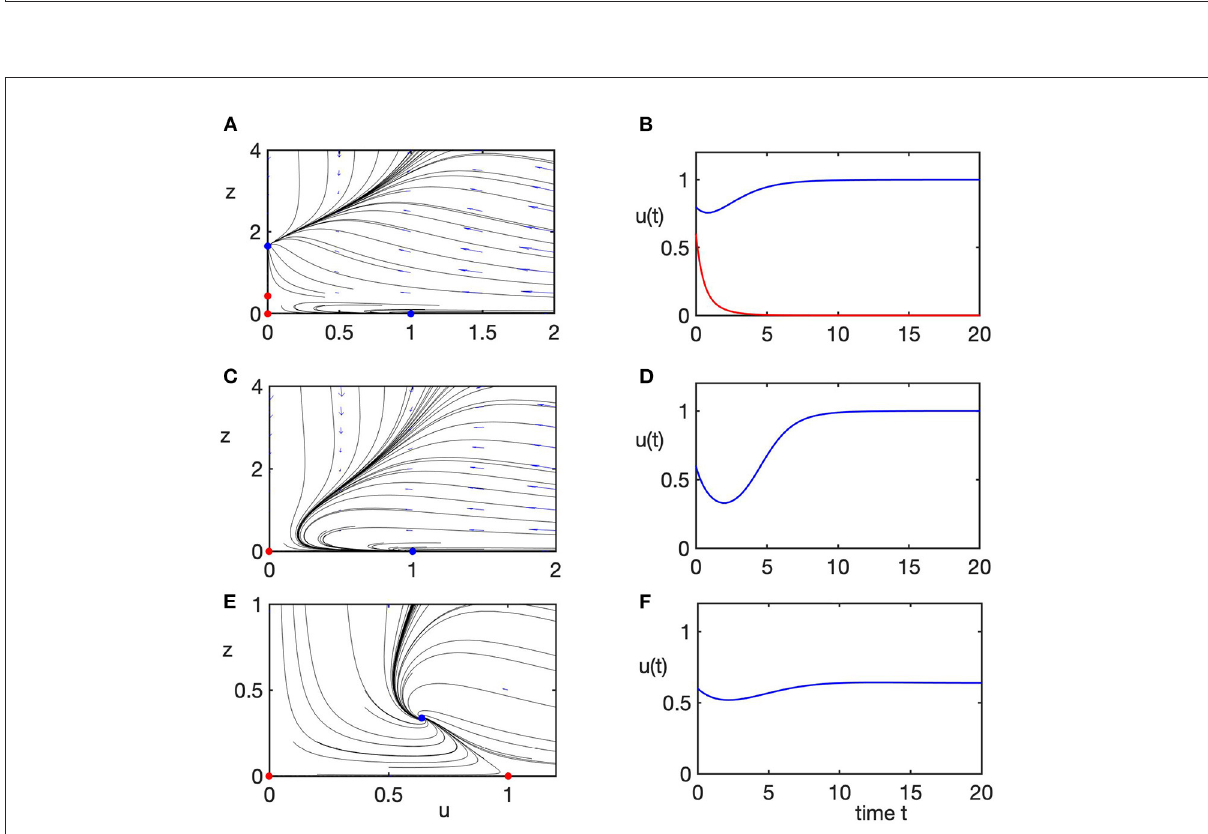
FIGURE4 Phase planes (left column) of the transformed system (Equation 5) and the corresponding numerical solution (right column) of the rescaled original system (Equation 4), illustrating different dynamical regimes listed in Figure 3A. Blue/red dots in phase plane plots indicate stable/unstable steady states. Parameter values are α = d = 1. (A,B) Case 1, a = 6, b = 0.5, bi-stability between prey-only steady state E and the extinction steady state E 0 . (C,D) Case 2, a = 3, b = 0.5, prey-only steady state E is the only stable state. (E,F) Case 3, a = 1.5, b = 1.4, only the coexistence steady state E ∗ is